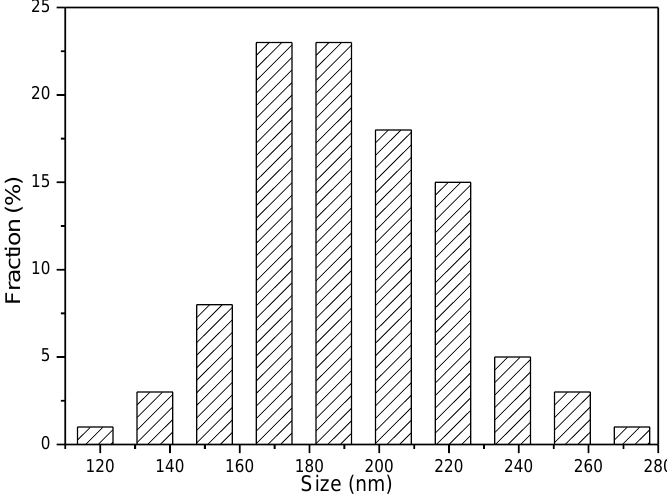
2 O 3 nanoparticles.